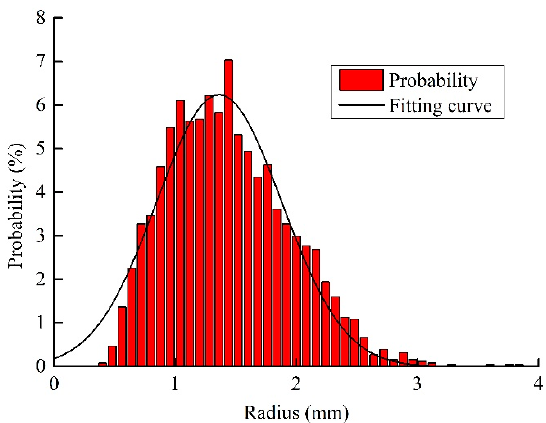
Figure 9. The size distribution of pores in foamed concrete.